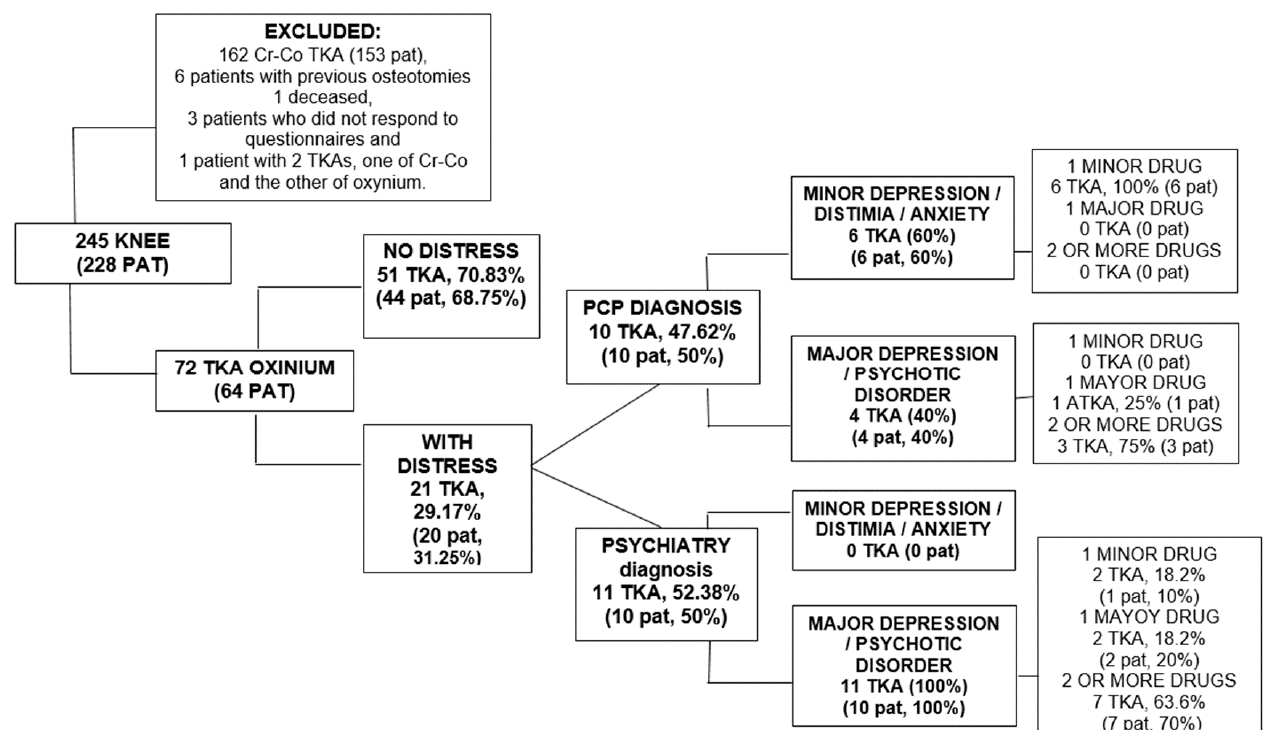
Figure 1. Patients flow chart with hypoallergenic TKA.